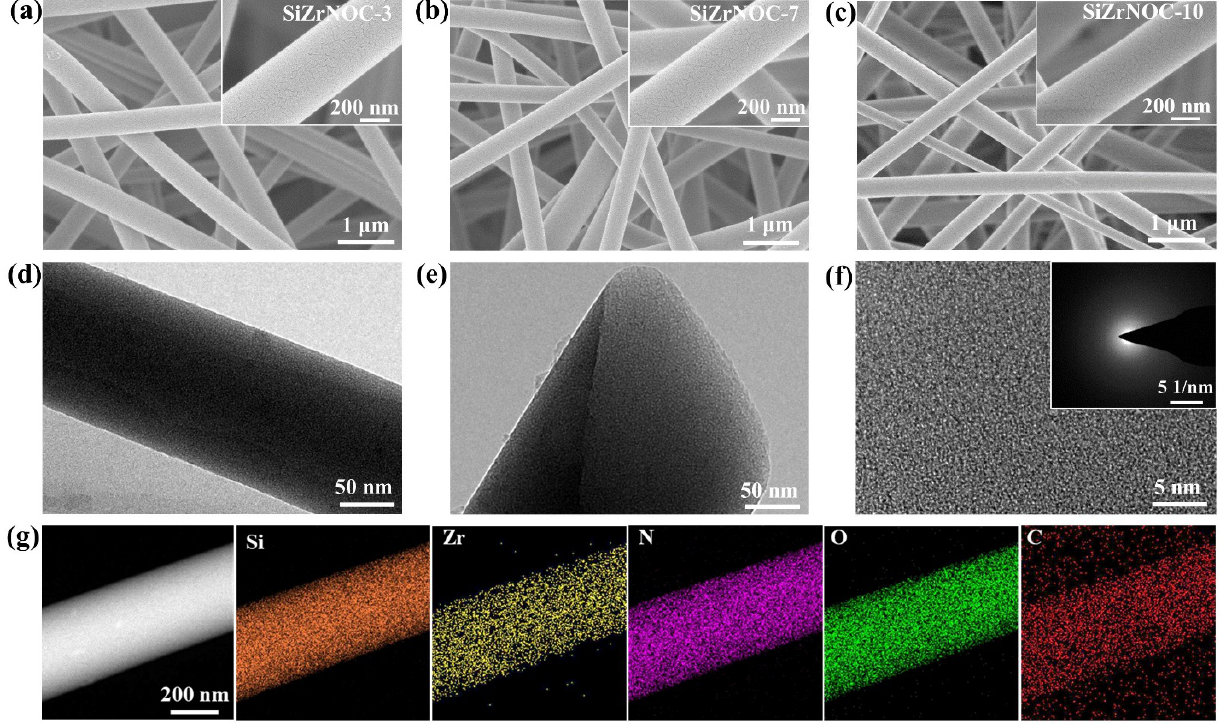
Fig. 2 SEM images of (a) SiZrNOC-3, (b) SiZrNOC-7, and (c) SiZrNOC-10 NFMs; (d, e) TEM images, (f) HRTEM image and SAED pattern, and (g) element mapping images of SiZrNOC-7